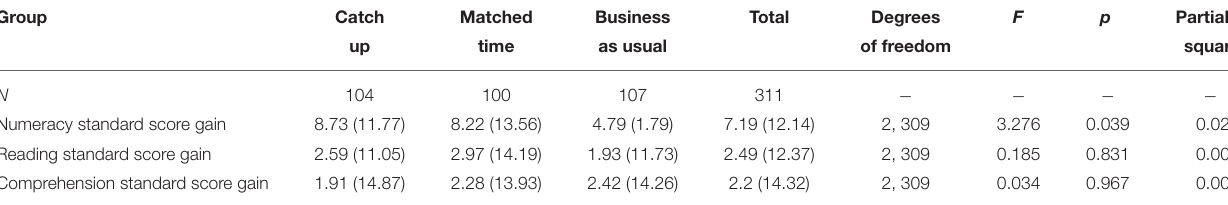
TABLE 4 | Pre-test scores of boys and girls and results of ANOVAs comparing genders.